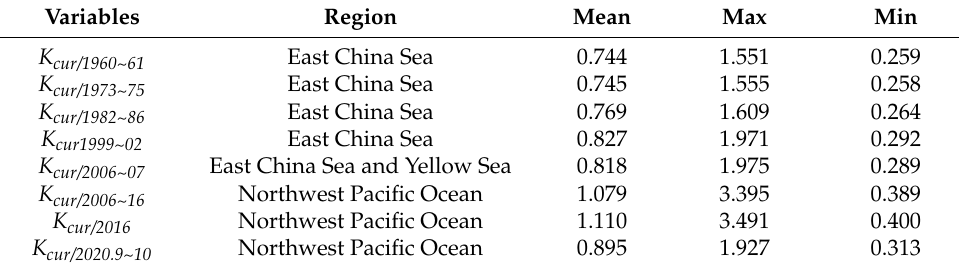
Table 4. Condition factors of Chub mackerel relative to reference